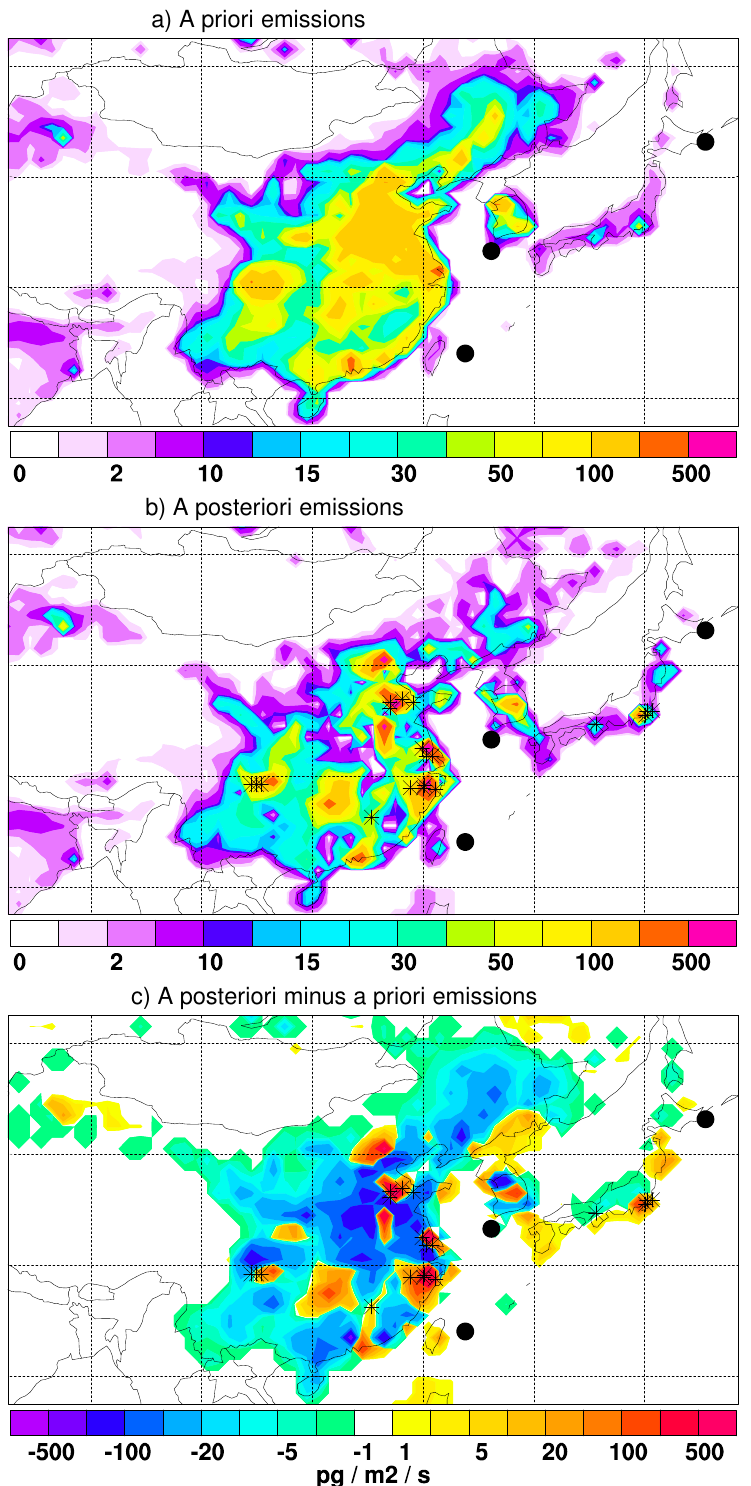
Fig. 4. Maps of the a priori (a) , a posteriori (b) , and difference between a posteriori and a priori (c) HFC-23 emissions for the year 2008. Black dots indicate the location of measurement stations, asterisks in panels (b) and (c) mark the locations of Chinese and Japanese factories known to have produced HCFC-22 in the year